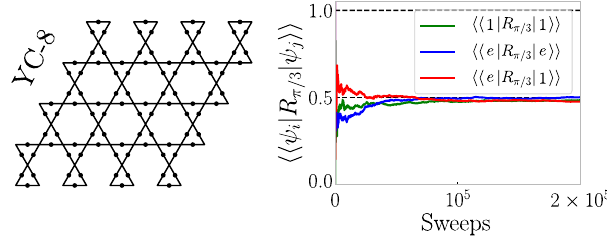
FIG. 11. Modular transformations on ruby lattice ( ρ ¼ 3 ) with V ð r Þ ∼ 1 =r 6 . For blockade radius R 3 . 8 a and detuning b ¼ δ = Ω ¼ 5 . 5 , we consider two topologically distinct ground states on the YC-8 torus as shown (see the main text and Appendix C for details). The overlaps after a π = 3 rotation agree with the universal value predicted for a Z 2 spin liquid. [As in Fig. 10, the simulation faithfully represents V ð r Þ within a distance r ≤ 9 a